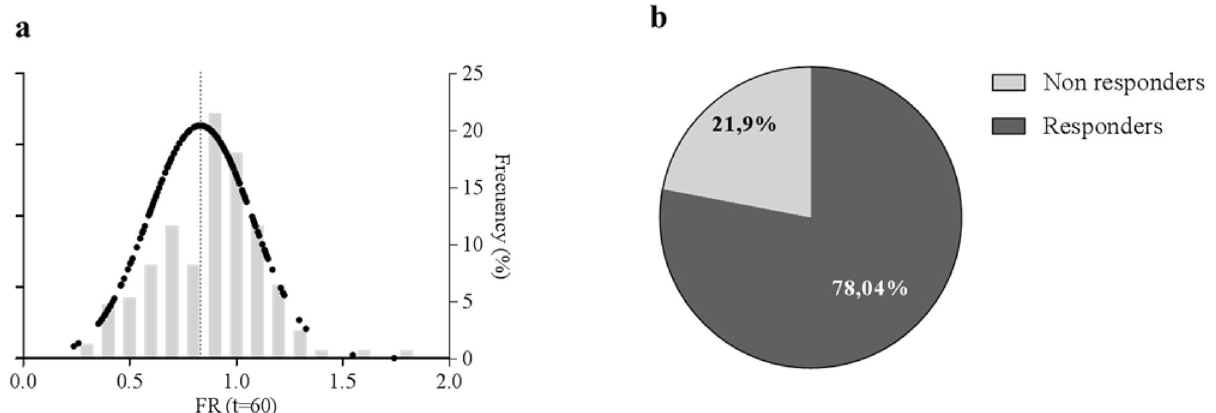
Figure 2. Distribution of FSK responses in WT nasospheroids. ( a ) WT nasospheroids present variability in FR values after 60 min FSK-incubation. Black dots show Gaussian distribution of FR values; right Y axis shows the frequency (%) of FR ranges. Each column represents 0.1 FR interval ranging from 0.2 to 1.7. The dotted line shows WT mean response to FSK (FR = 0.803). ( b ) Distribution of nasospheroids according to their response depending on their FR at t = 60 min. FR ≤ 1 was set for responders and FR > 1 for non-responders . Graphic created with GraphPad Prism version 6 33 .